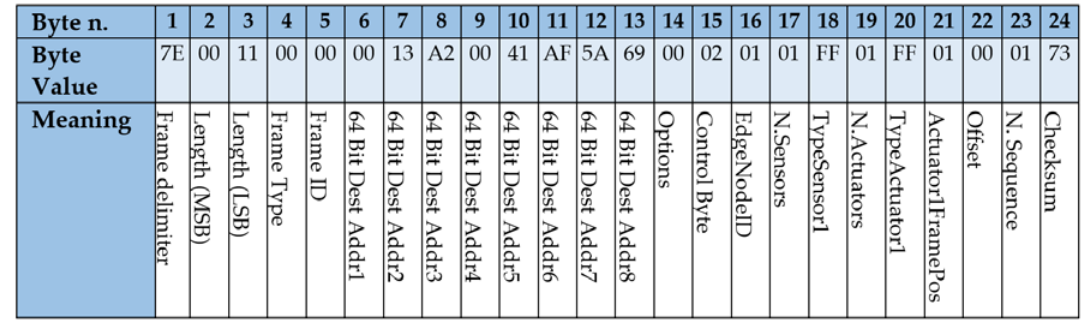
Figure 5. Measurement frame used by the microcontroller at the Edge Nodes with the process values for a SISO control system.